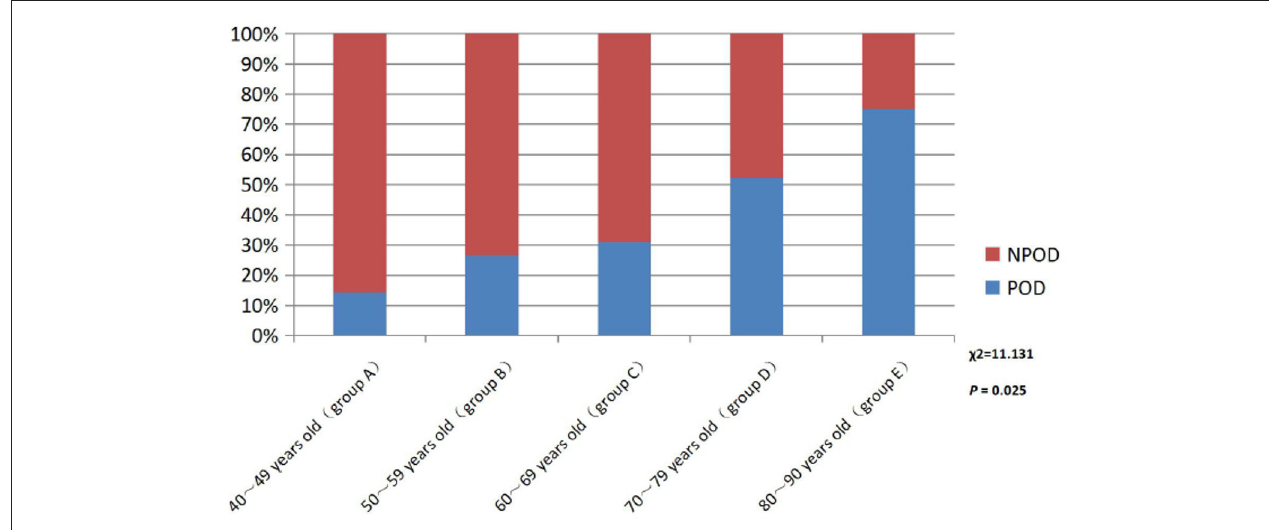
FIGURE 2 | Comparison of POD incidence in different age groups patients with SCD. POD, post-operative delirium; NPOD, non-post-operative delirium.